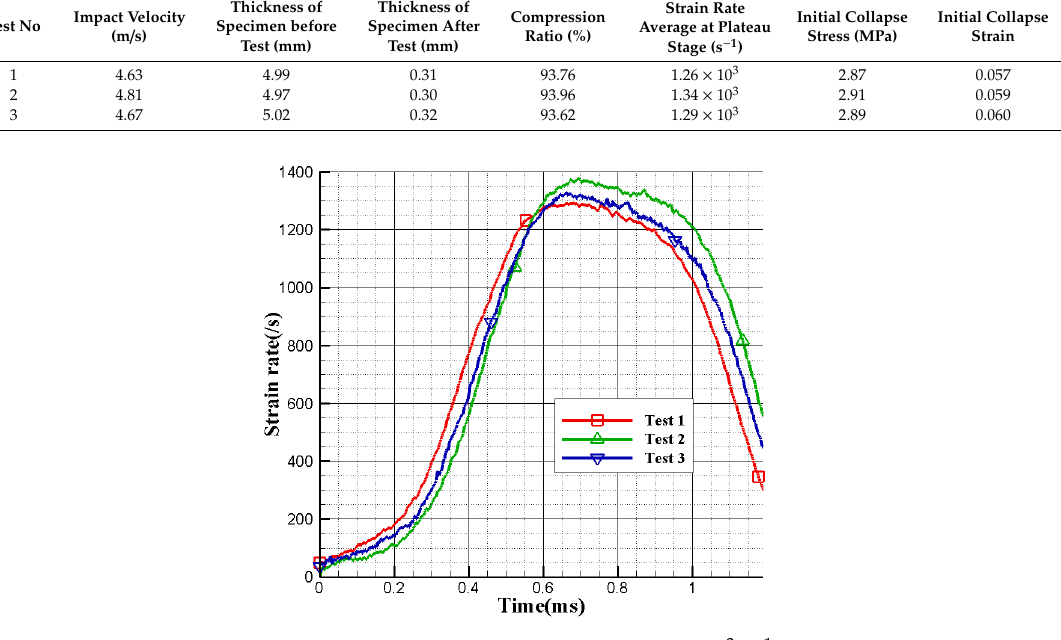
Figure 9. Strain rate curve at strain rate 1.3 × 10 3 s − 1 .